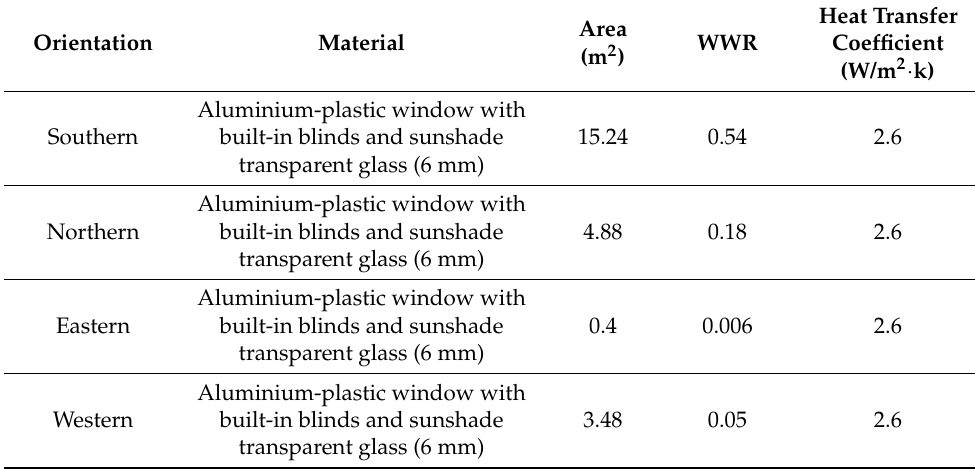
Table 3. External Window Construction details and WWRs (adapted from